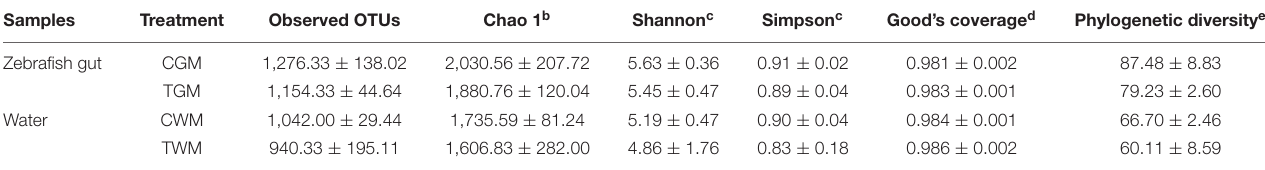
Samples Treatment Observed OTUs Phylogenetic diversity